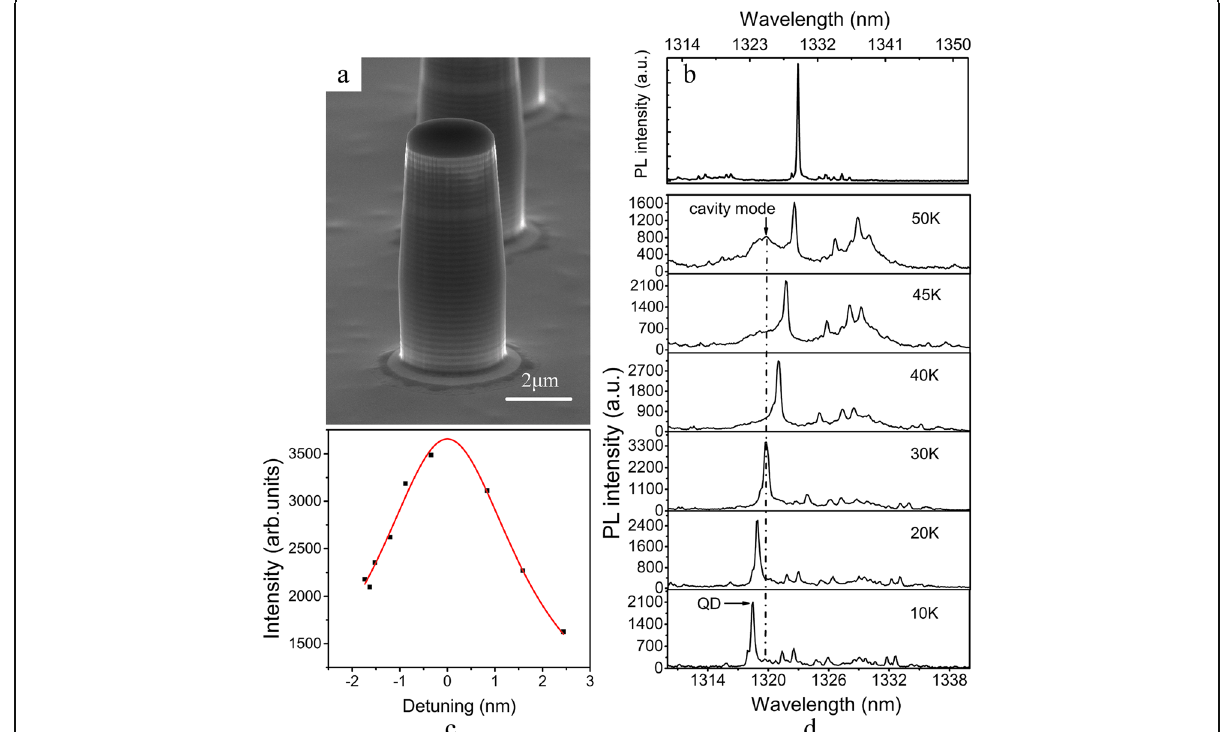
Fig. 2 a SEM image of the micropillar structure (diameter ~3 μ m). b Typical PL spectrum of a single BQD in micropillar at 4 K. d Temperature- dependent μ PL spectra of a typical BQD in micropillar and c its integrated PL intensity as a function of the exciton-cavity detuning under excitation power ~2 μ W, red line : Lorentzian